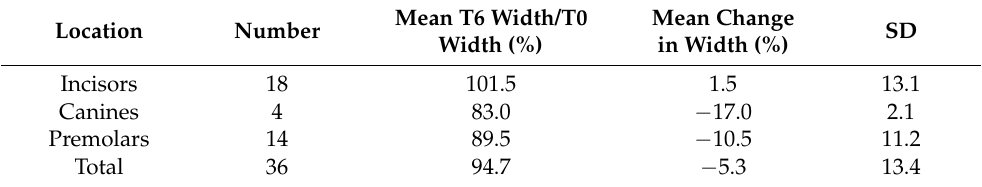
Table 1. Mean and SD of changes in the alveolar width in the different treated sites.